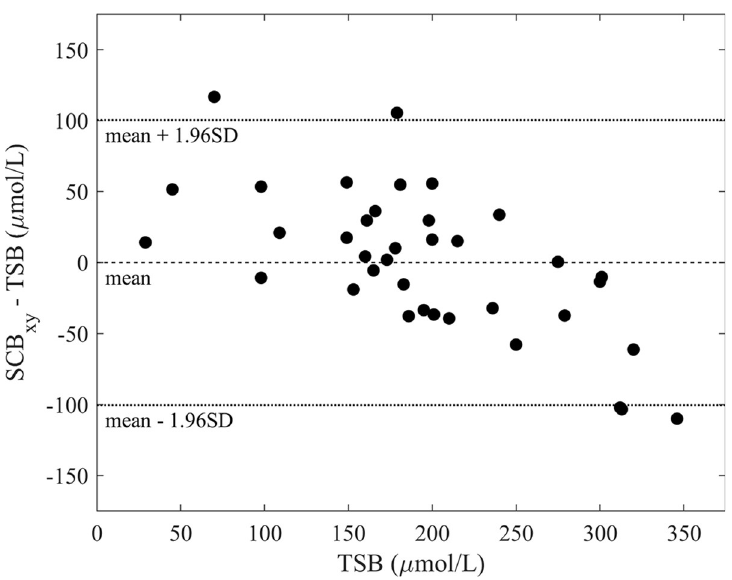
Fig 5. Bland-Altman plot for TSB and SCB xy derived from ambient-subtracted scleral chromaticity.